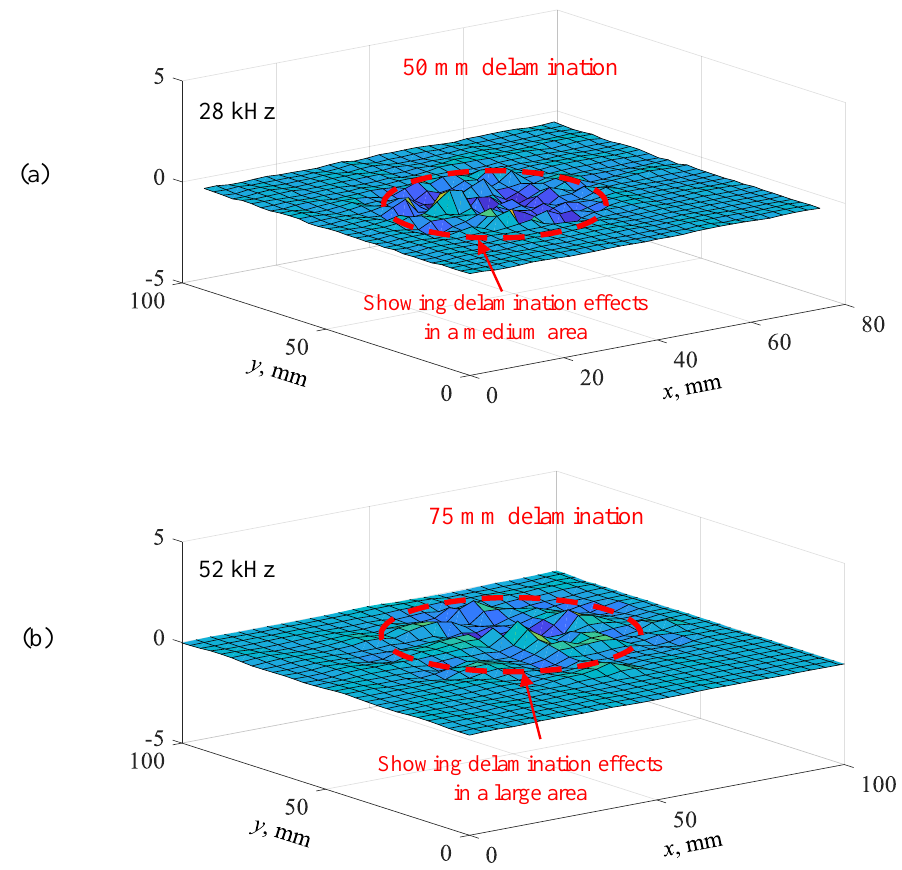
Figure 19. Measured operational vibration shapes on the cross-ply CFRP composite plate: ( a ) 50 mm delamination at 28 kHz; ( b ) 75 mm delamination at 52 kHz.